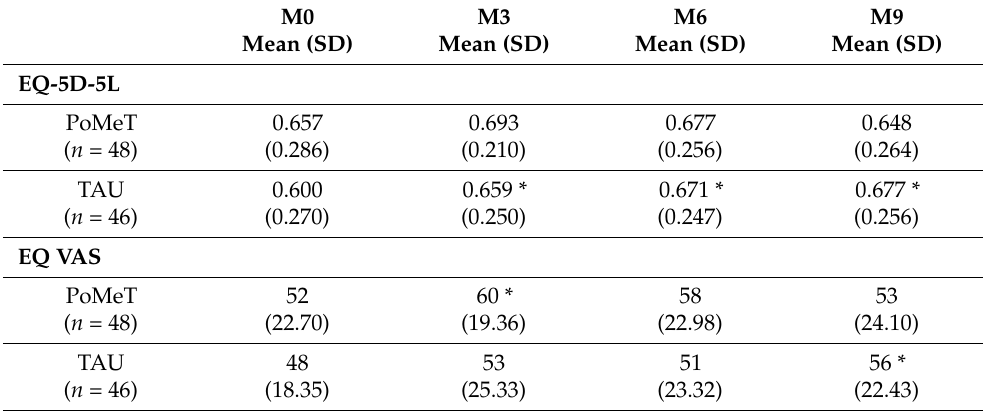
Table 2. Health-related quality of life results (EQ-5D-5L, EQ VAS).